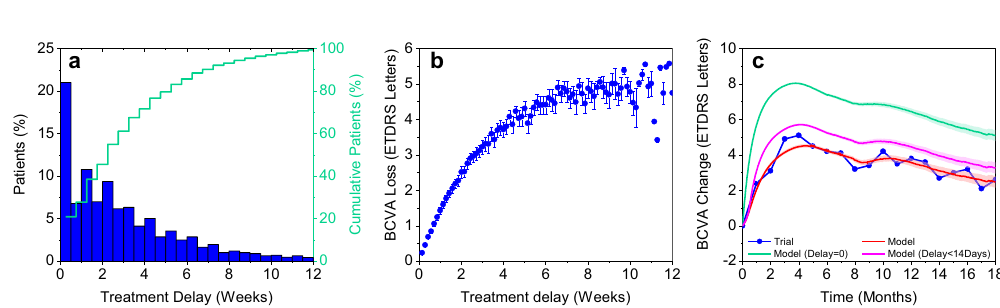
Figure 3. Model prediction for mean BCVA change from baseline with 95% prediction interval in a 3l-q8w treatment scenario (green) and a scenario without treatment (purple) vs. the real-world scenario of OCEAN (blue, red). The 3l-q8w scenario consists of 3 loading injections q4w without delay between baseline visit and first injection, followed by injections q8w until Month 18. Baseline characteristics are as in OCEAN. BCVA = best corrected visual acuity.